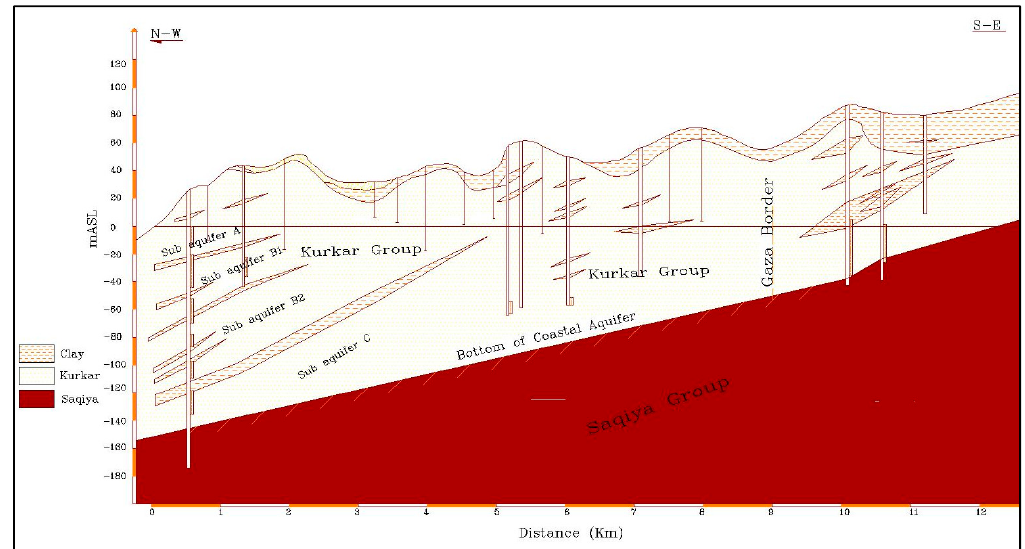
Figure 1. Typical cross-section of the Gaza Aquifer (after [26]).